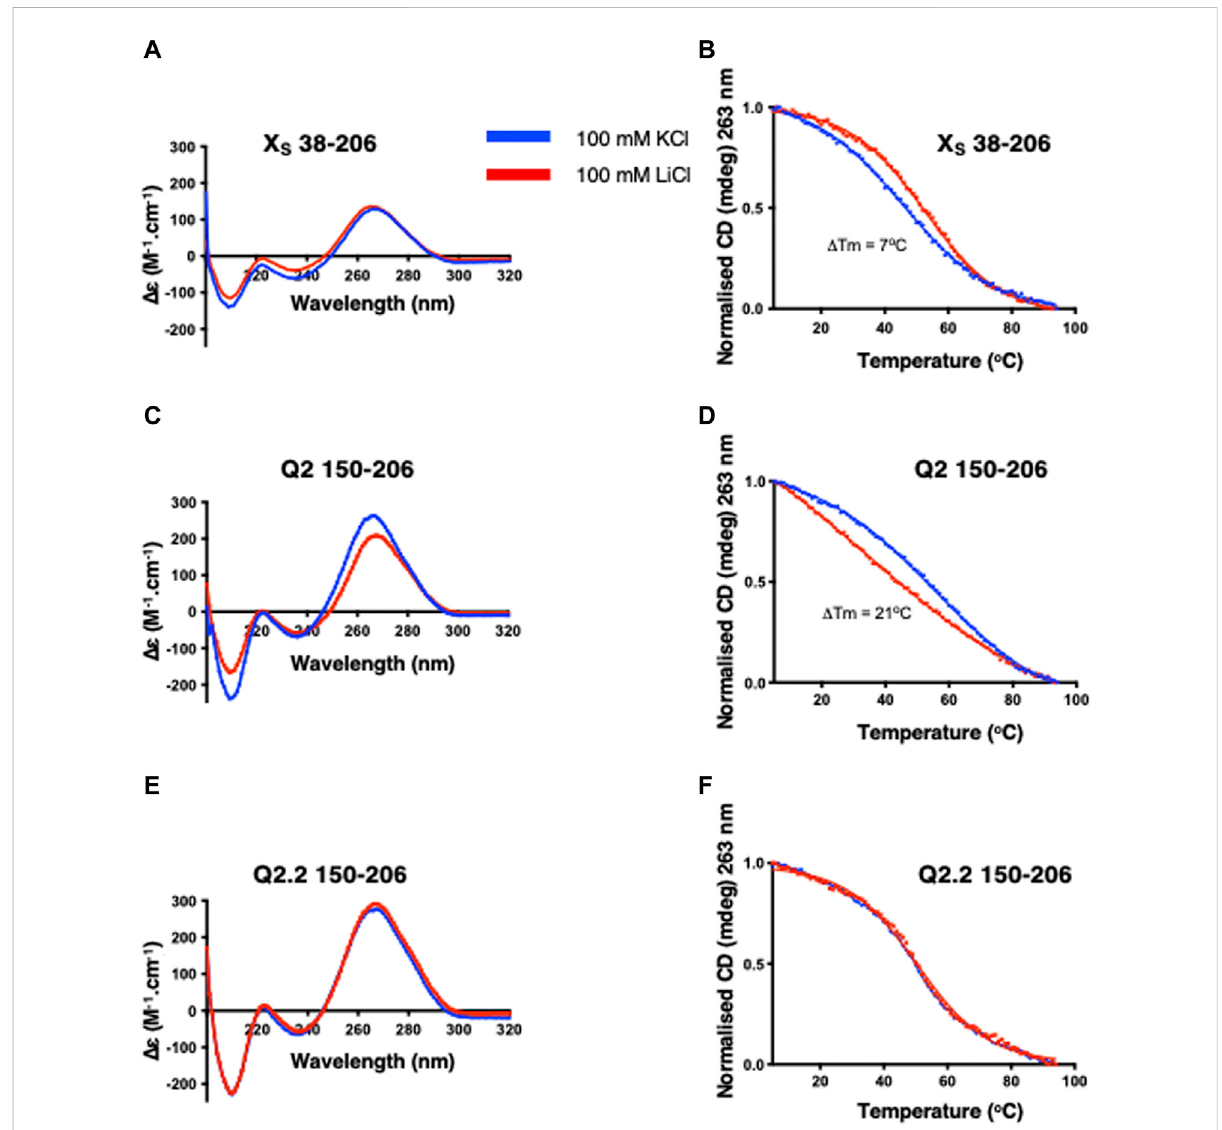
FIGURE 2 CDspectraandthermaldenaturationmeltingcurvesoftheindicatedBcl-xfragments.CDat20 ° Candthermalmeltingcurvesinthepresenceof either KCl (blue) or LiCl (red) of X S 38 – 206 (A,B) , Q2 150 – 206 (C,D) and Q2.2 150 – 206 (E,F) . All experiments were carried out with 2 µM RNA in 10 mM TBA phosphate buffer pH 7.0 with 100 mM salt in a 1 cm pathlength quartz